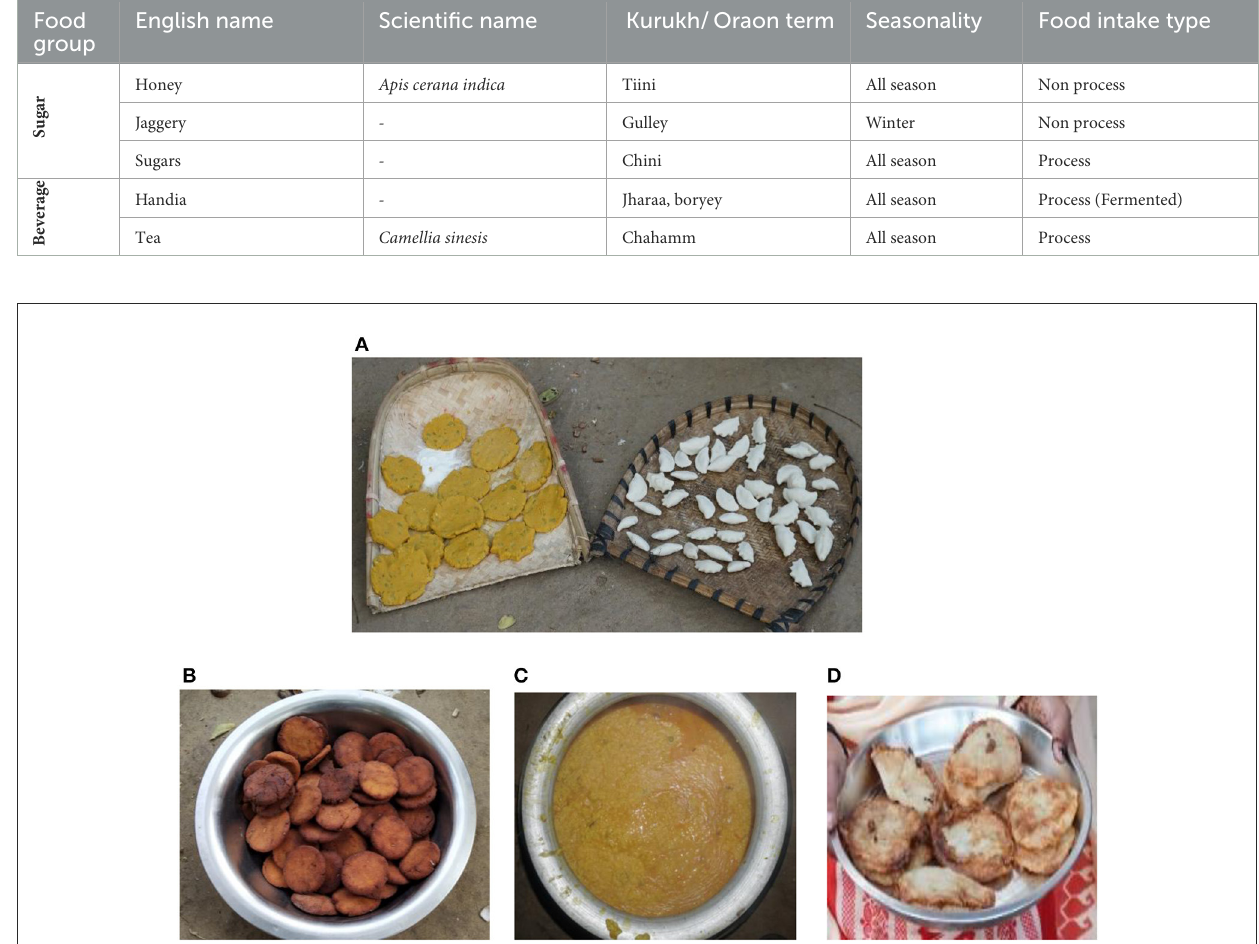
FIGURE1 Festive foods: (A) Different types of pitha (cake). (B) Gur-pitha. (C) Bhog is made for god. (D)